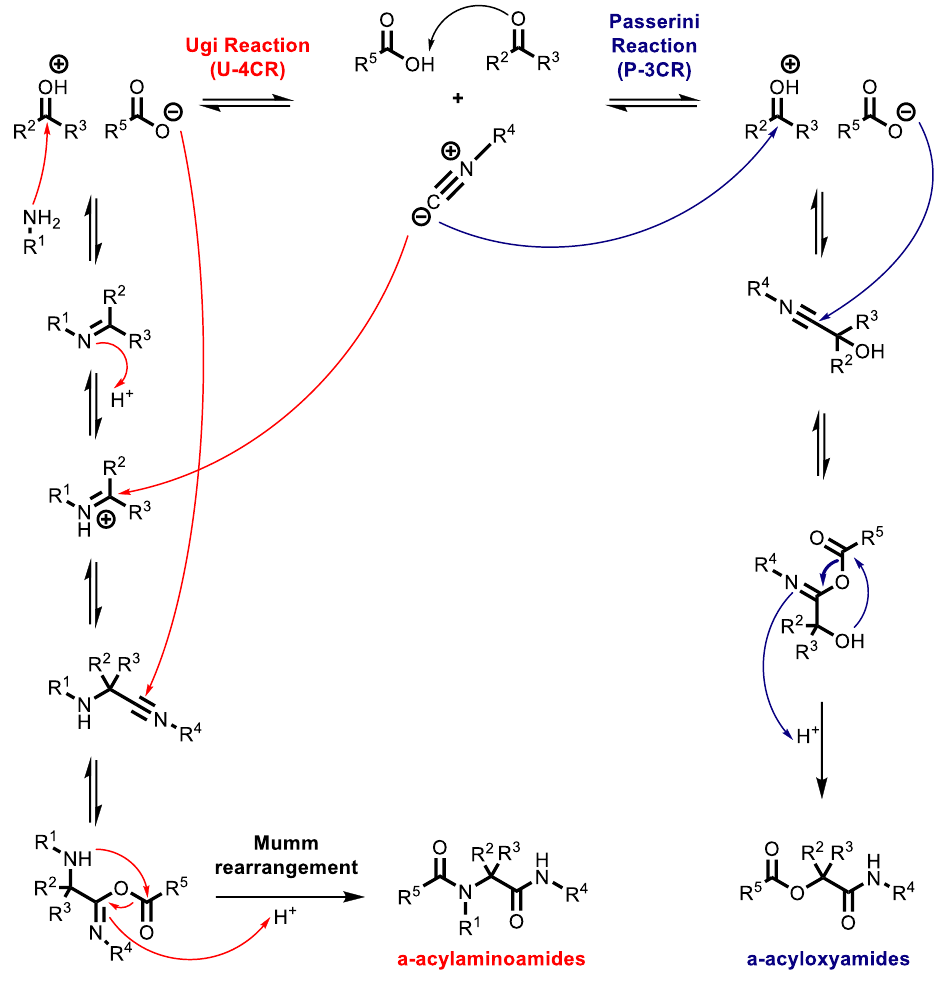
Scheme 1. Mechanism of Ugi and Passerini